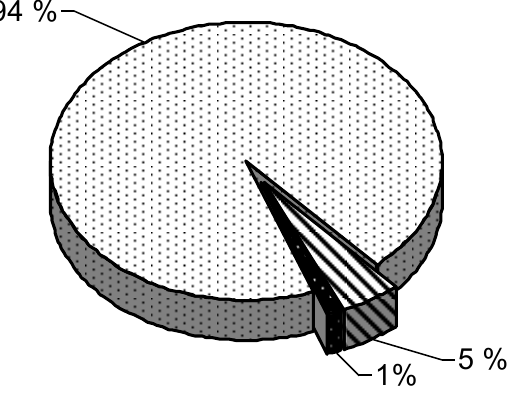
Fig.1. Significance of psychological training in tennis as per questioning of experts